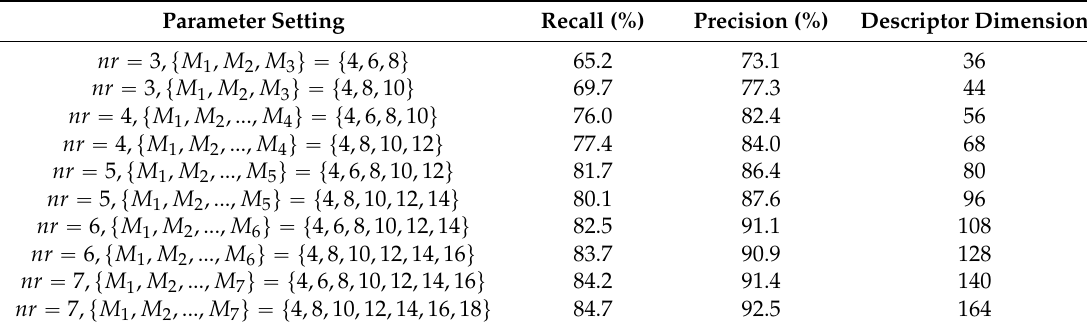
Table 3. Average results of the accuracy with different